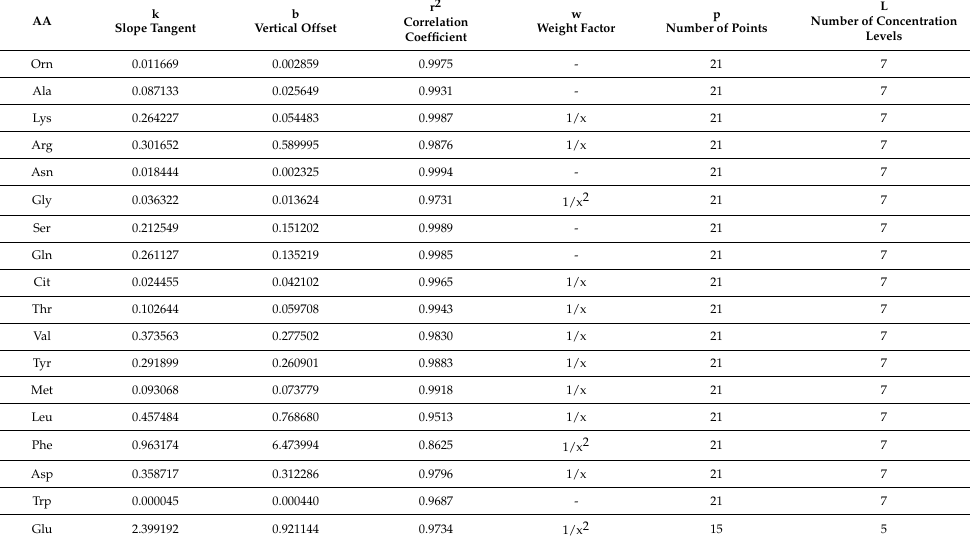
Table 7. Characteristics of the calibration curves of the analyzed amino acids obtained using triple quadrupole MS. Calibration curves were built by equal correlation within seven concentration levels, in three technical repetitions for each of the levels for glutamic acid, five concentration levels were used, except for two upper limit levels. Amino acids are presented in ascending order of retention time. r2 b Correlation VerticalOffset